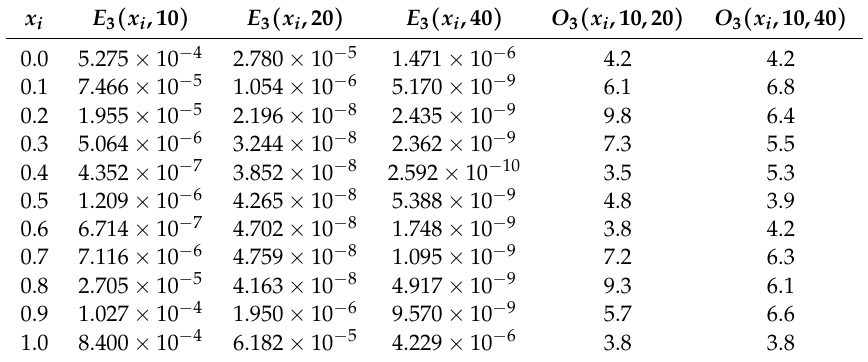
Table 5. The absolute errors of the third order derivatives of y 1 at the knots and the numerical convergence orders.